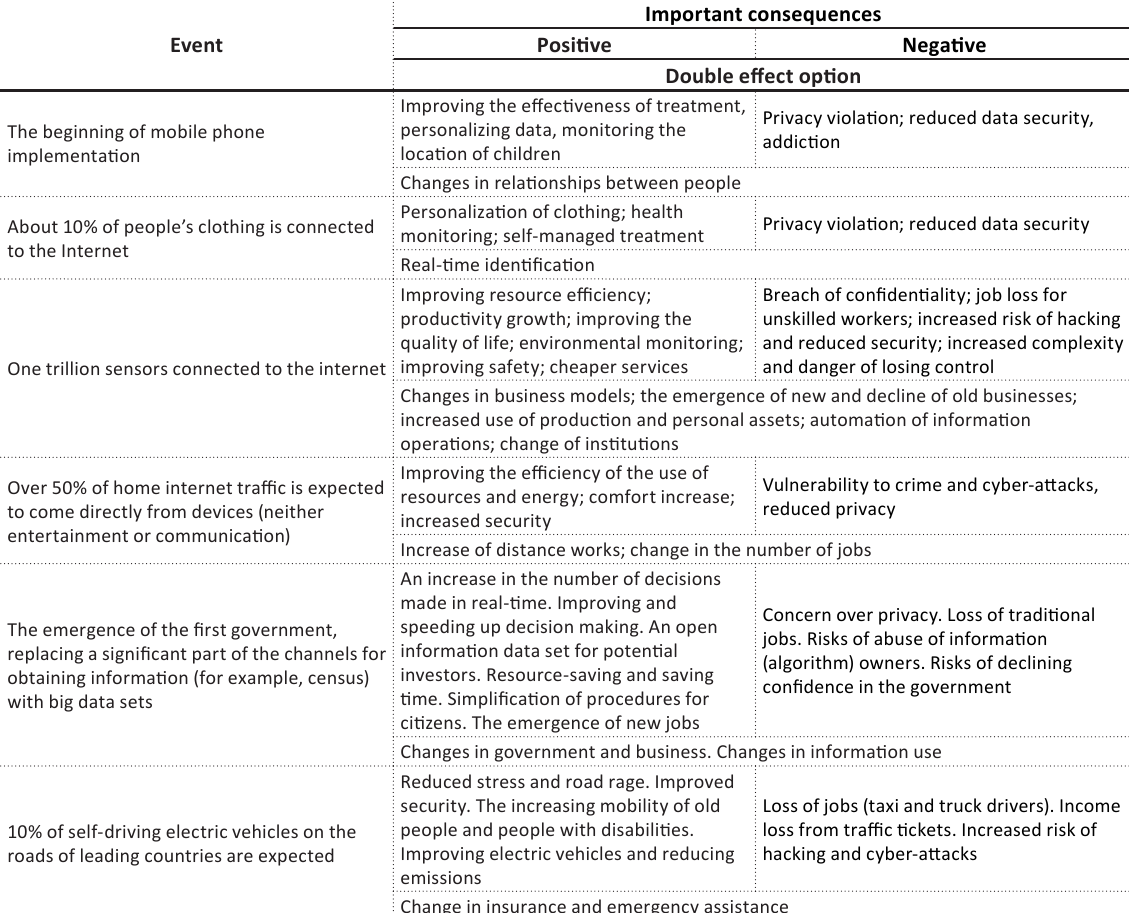
Table 3. Forecast of the most important developments in the internet of things for